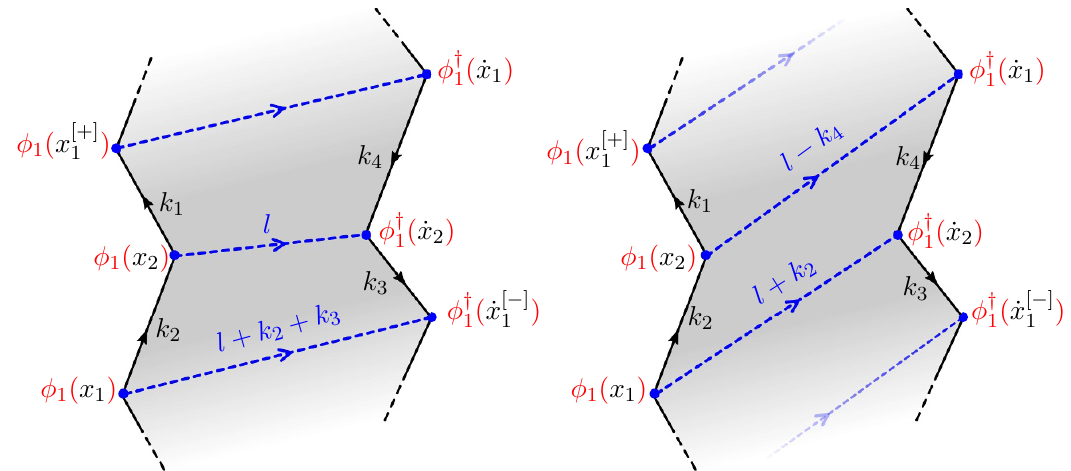
Figure 5 . The two types of diagrams that contribute to the Wilson lines correlator (3.8). The dual space picture consists of two in(cid:12)nite null polygonal Wilson lines composed of two sets of scalars, f (cid:30) 2 ( x [ a ] ) = ( h 1 2 i c 2 ) ; (cid:30) 2 ( x [ a ] ) = ( h 2 1 i c 2 ) g and f (cid:30) y ( _ x [ a ] ) = ( h 3 4 i c 2 ) ; (cid:30) y ( _ x [ a ] ) = ( h 4 3 i c 2 ) g , contracted along 0 0 0 0 1 2 2 1 2 2